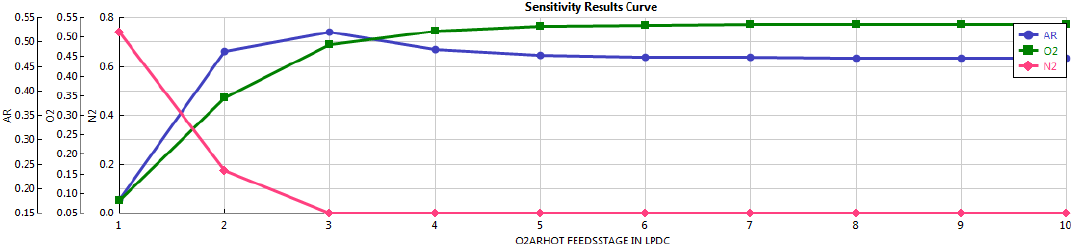
Figure 13. ARO2RECT molar fractions vs O2ARHOT Feed stage location in the LPDC.